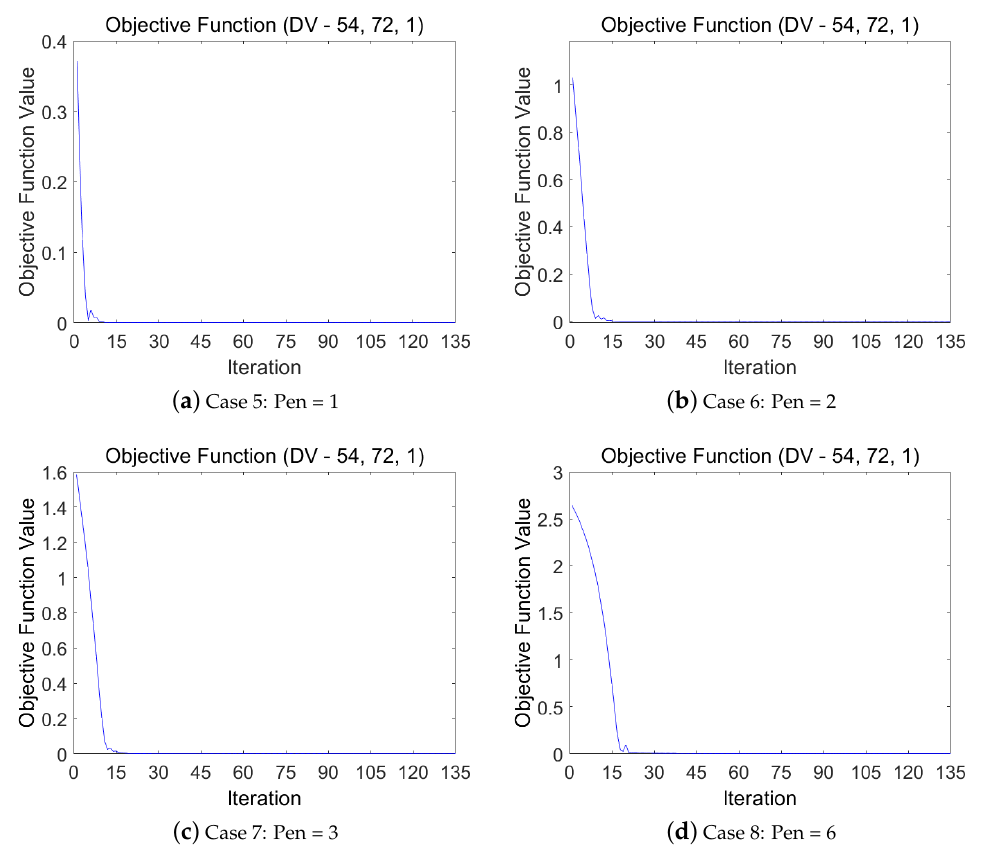
Figure 13. Objective function convergence for Cases 5, 6, 7 and 8.